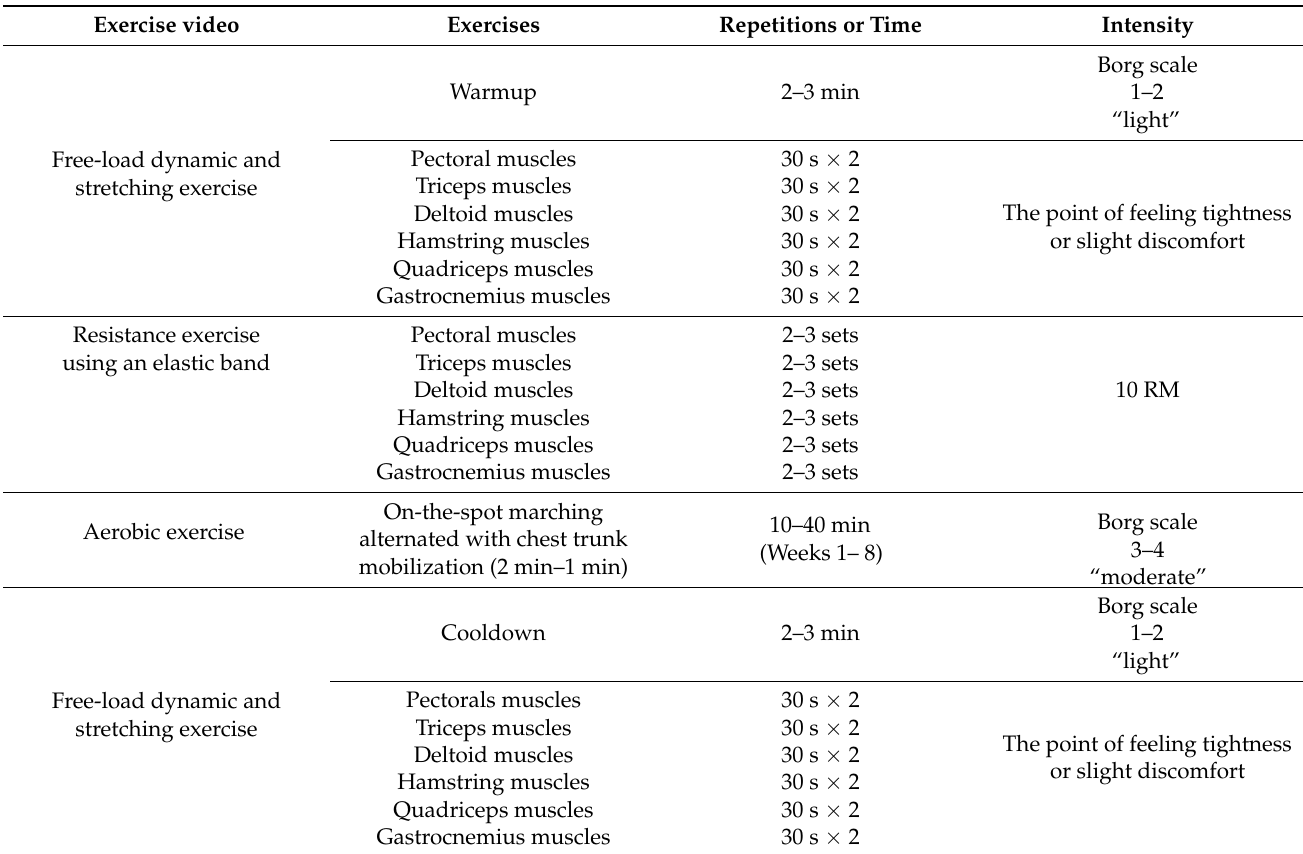
Table 1. Exercises included in the